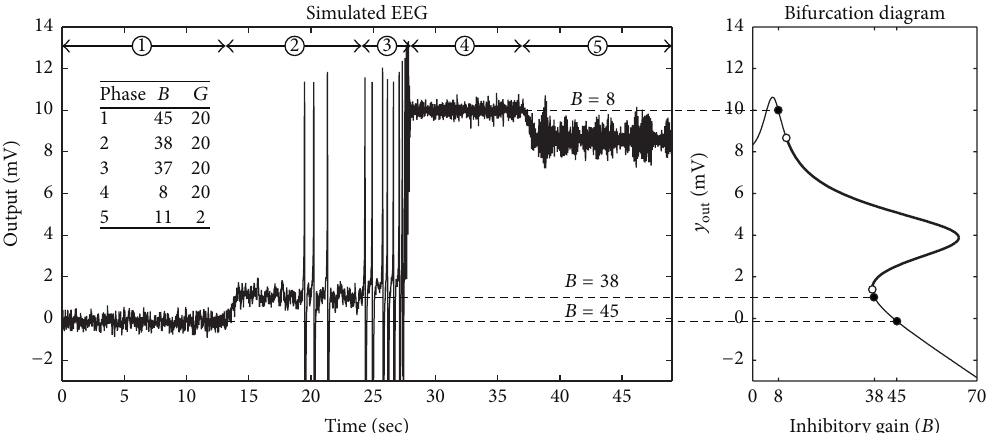
Figure 2: Example of DC offset in the model. (Left) Recreation of simulation of five different dynamical behaviors shown in Wendling et al. [18]. The inset shows values for parameters 𝐵 and 𝐺 that vary for each phase while 𝐴 is fixed at 5. (Right) A bifurcation diagram showing the nullcline that predicts the DC offset based on the inhibitory gain, 𝐵 , for three different values (8, 38, and 45). Filled circles are stable equilibrium points that correspond to similar mean values in the simulated EEG on the left (dashed lines). Open circles indicate bifurcations betweenstabilityandinstabilityonthenullcline.Thedarklinebetweentheopencirclesrepresentsacontinuousregionofunstableequilibrium